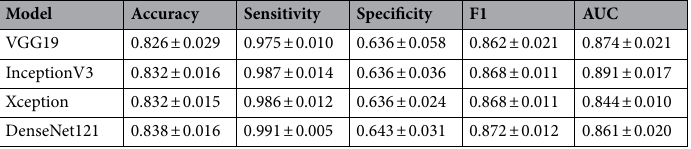
Table 1. Quantitative results in comparative study of different convolutional neural network (CNN)